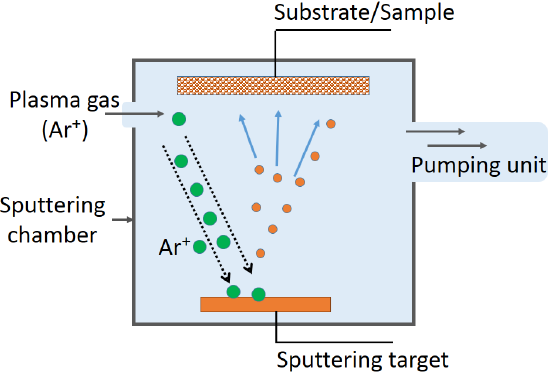
Figure 1. Sputtering unit used during the sputtering of antibacterial layers on diverse substrates.